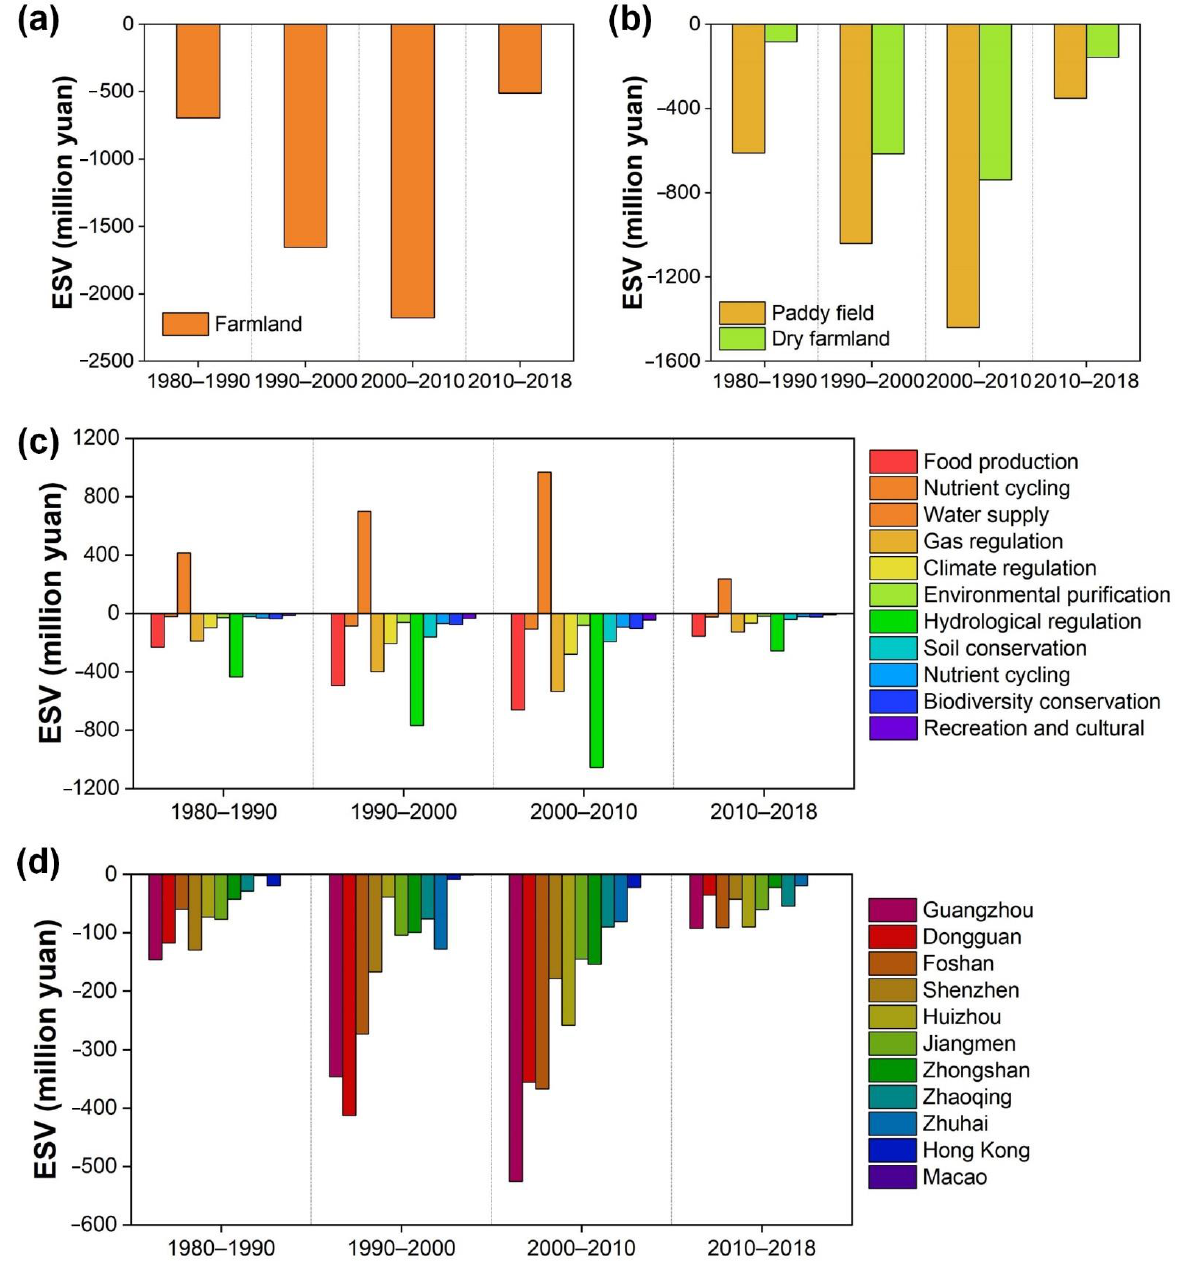
Figure 6. The ecosystem service value (ESV) loss of farmland encroached by urbanization in the GBA during the four study periods: ( a ) is the ESV loss of farmland converted to construction land in the GBA during the four study periods; ( b ) is the ESV loss of different farmland types converted to construction land in the GBA during the four study periods; ( c ) shows the variation of ecosystem service losses of farmland due to urbanization in the GBA during the four study periods; and ( d ) is the ESV loss of farmland converted to construction land in the 11 cities during the four study periods.